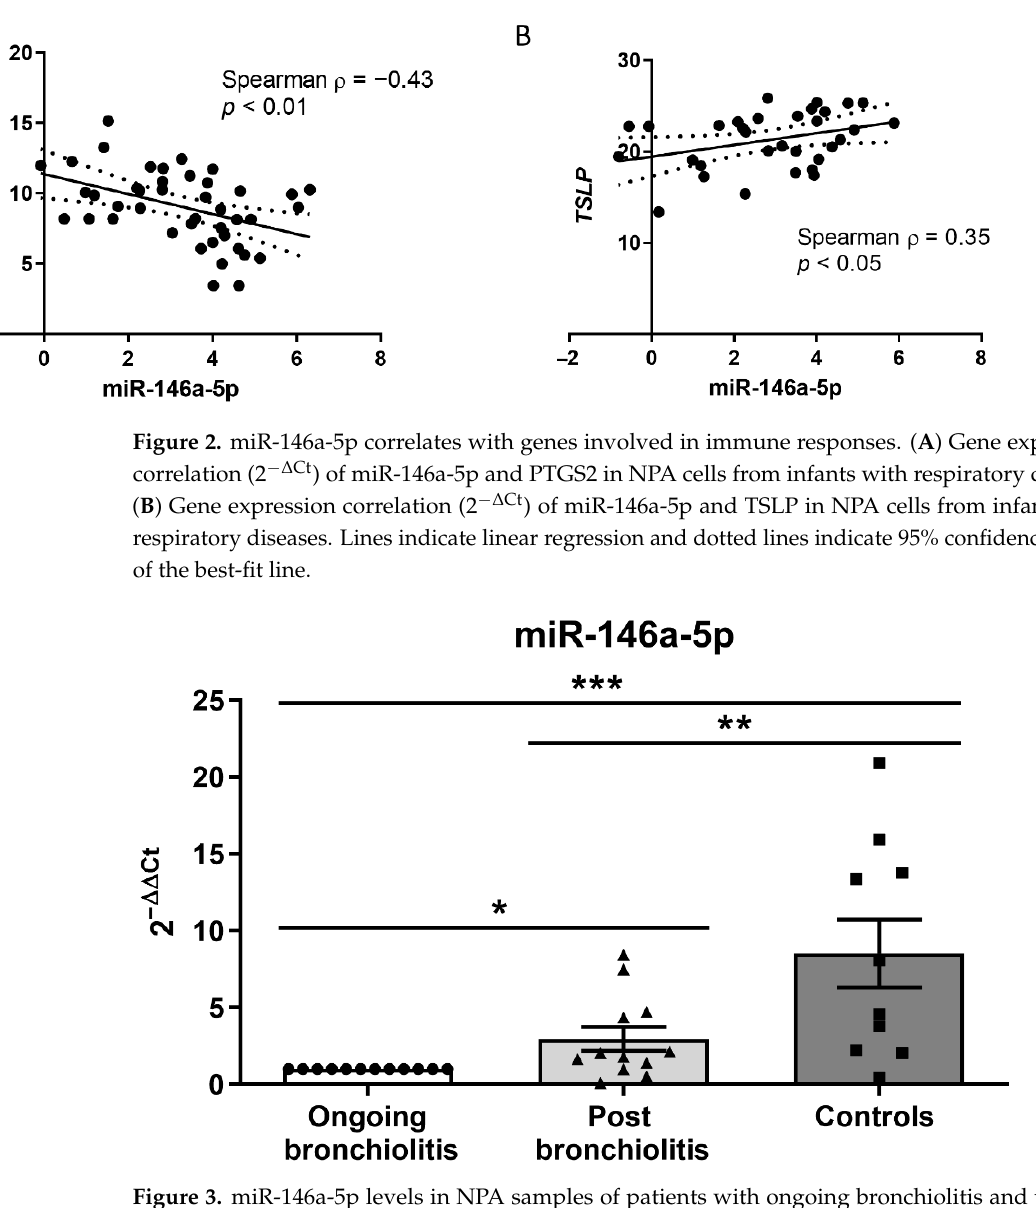
Figure 3. miR-146a-5p levels in NPA samples of patients with ongoing bronchiolitis and patients in post-recovery. MiR-146a-5p expression (2 − ∆∆ Ct ) in infants with ongoing bronchiolitis, post-bronchiolitis, and controls. * p < 0.05; ** p < 0.01; *** p < 0.001. Dots represent ongoing bronchiolitis individuals; triangles represent post bronchiolitis individuals and squares represent control individuals.